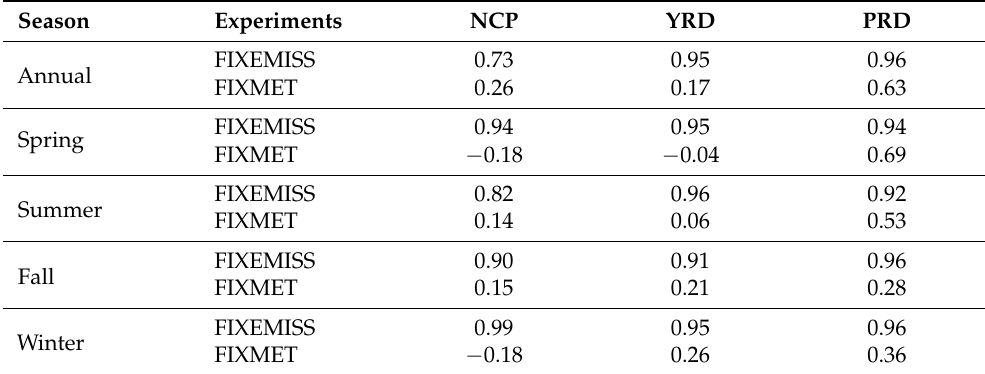
Table 3. Correlation coefficients of r PM-AOD in the BASE experiment with those in FIXEMISS and